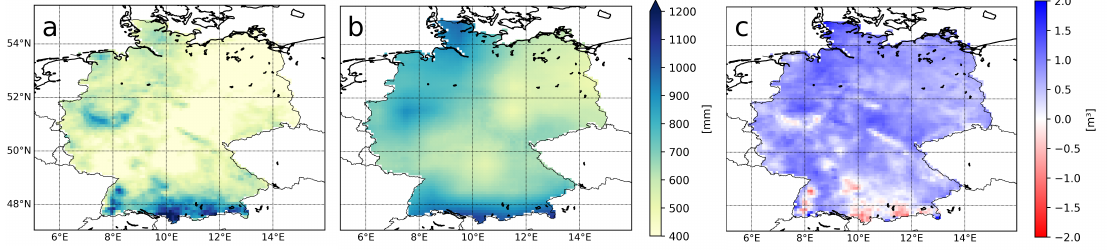
Figure 2. Yearly mean precipitation sum over Germany from RADOLAN ( a ) and GPM ( b ) data and the overall difference (GPM − RADOLAN) calculated for the period under review ( c ).